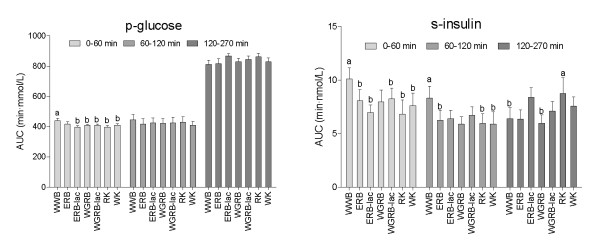
Glucose and insulin responses after the breakfast products. Values are means ± SEM, n = 10 (n = 9 for WGRB). Products not sharing the same letters were significantly different. Products not displaying letters were not different from any other test product, p < 0.05 (ANCOVA, followed by Tukey's test).